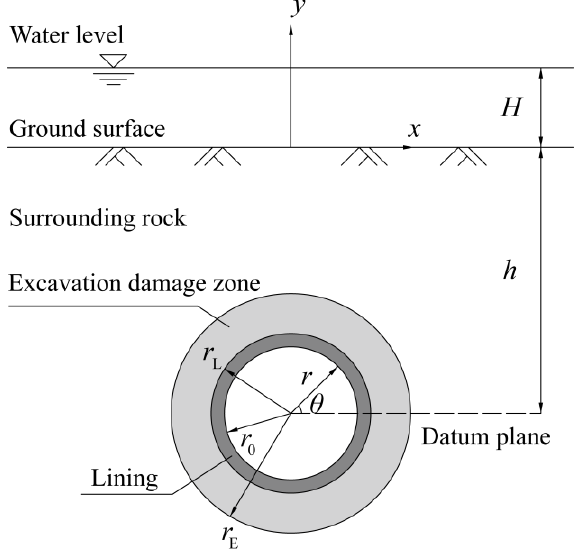
Figure 1. Simplified model of a circular underwater tunnel with an EDZ in a semi-infinite aquifer with a horizontal water level: H , depth from the water level to the ground surface; h , depth from the ground surface to the tunnel center; r 0 , internal radius of the tunnel; r L , radius of the tunnel with lining; r E , radius of the tunnel with lining and the